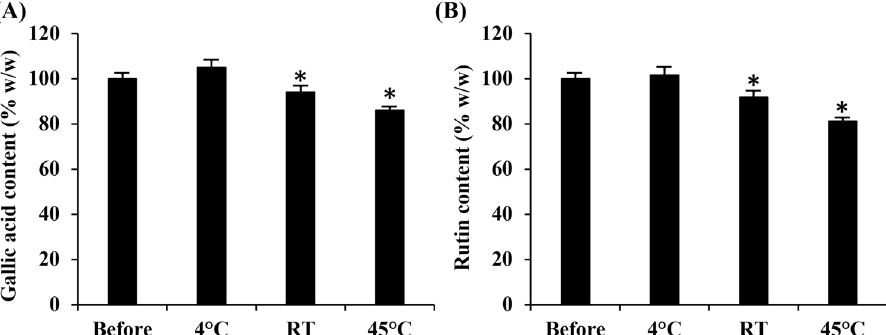
Figure 4. Gallic acid content ( A ) and rutin content ( B ) from the ethanolic extract of A. officinalis spears dried at 50 °C for 24 h before and after storage at various temperatures for 3 months. Asterisk (*) denotes significant difference between gallic acid and rutin content before and after the stability test ( p <